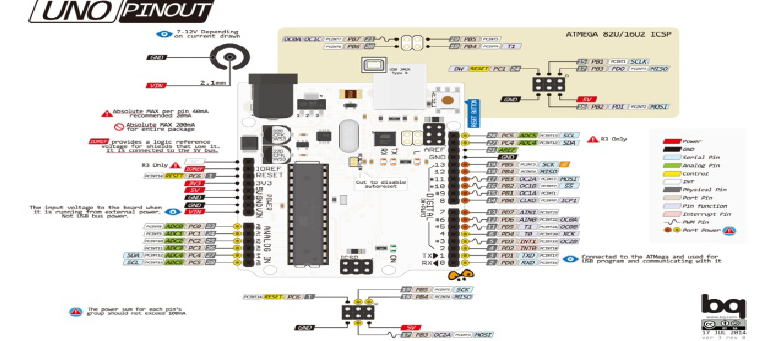
Fig. 3. Pinout of ATMEGA328P